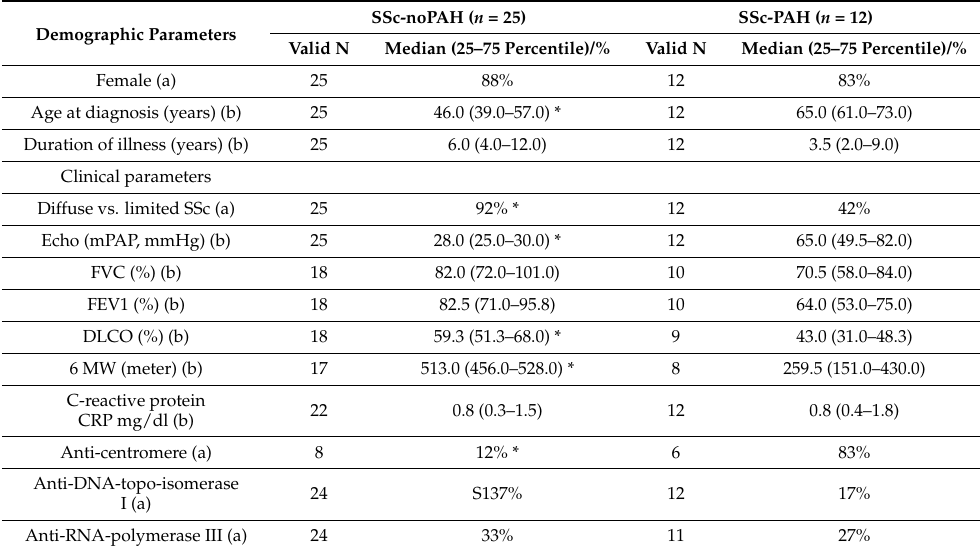
Table 1. Demographic and clinical characteristics of the